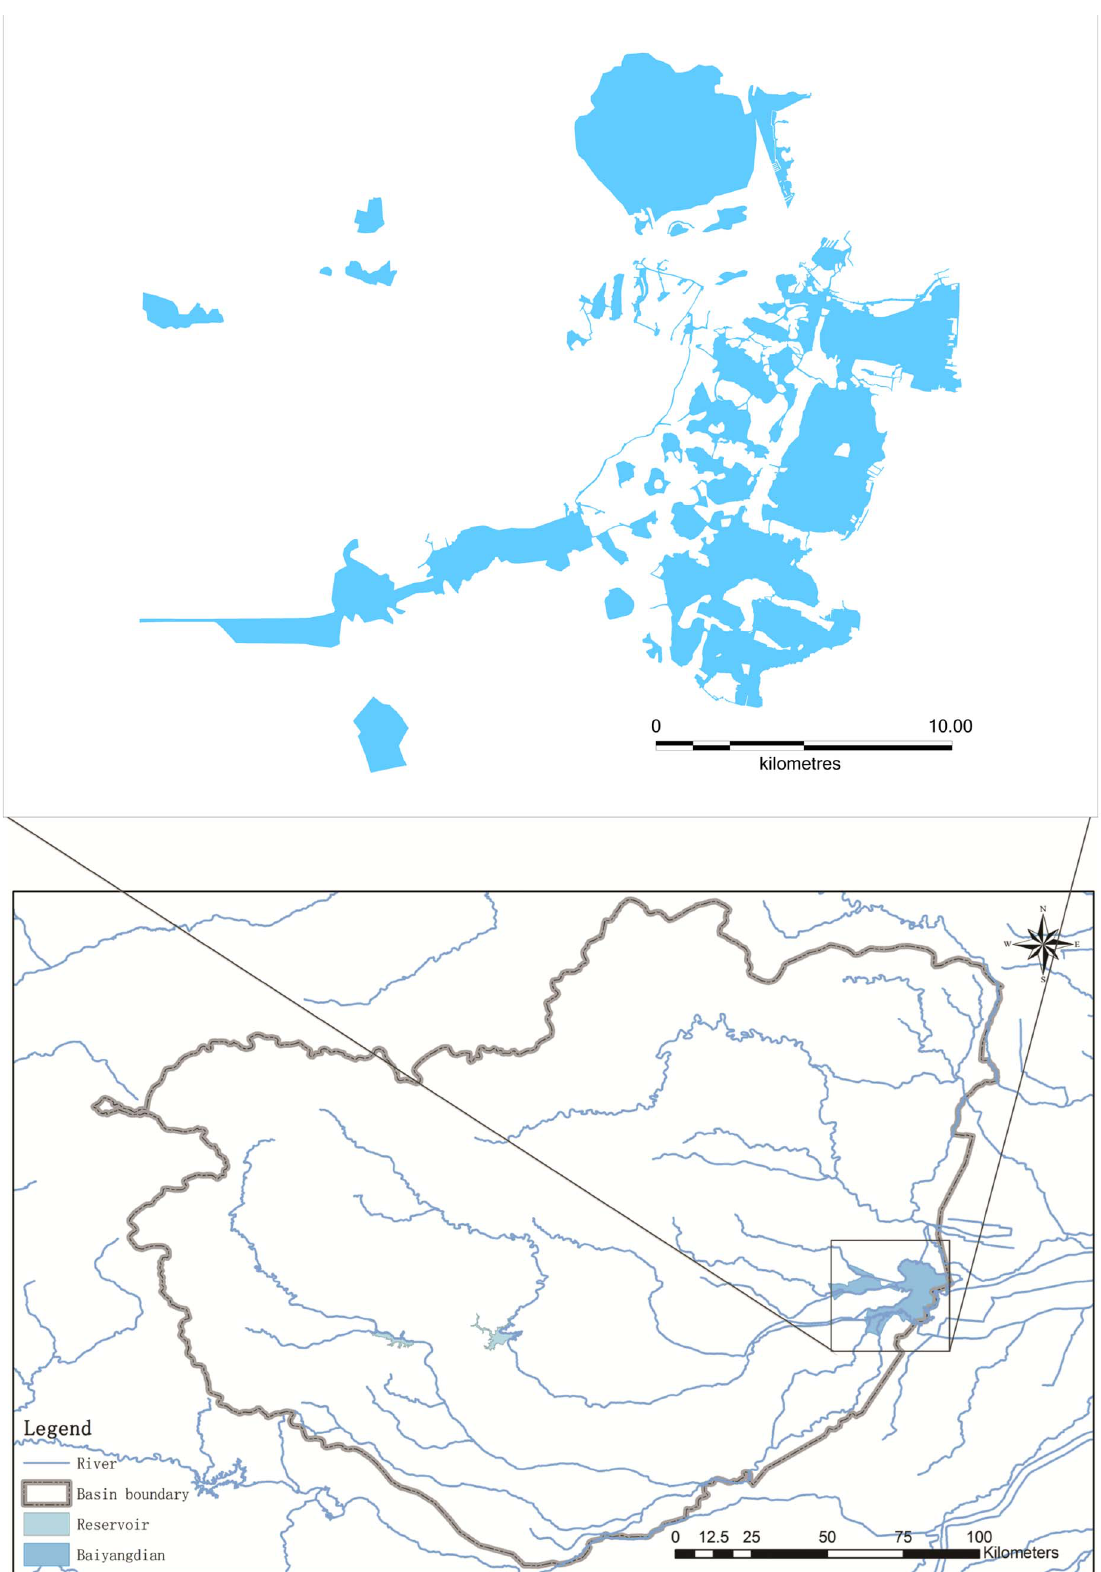
Figure 1. The Baiyangdian wetland and basin. The Baiyangdian wetland is the largest semi-closed wetland in the Hai River basin. Nine Rivers, with a catchment area of 31,200 km 2 , joins the Baiyangdian wetland and then flows into the Bohai Gulf.